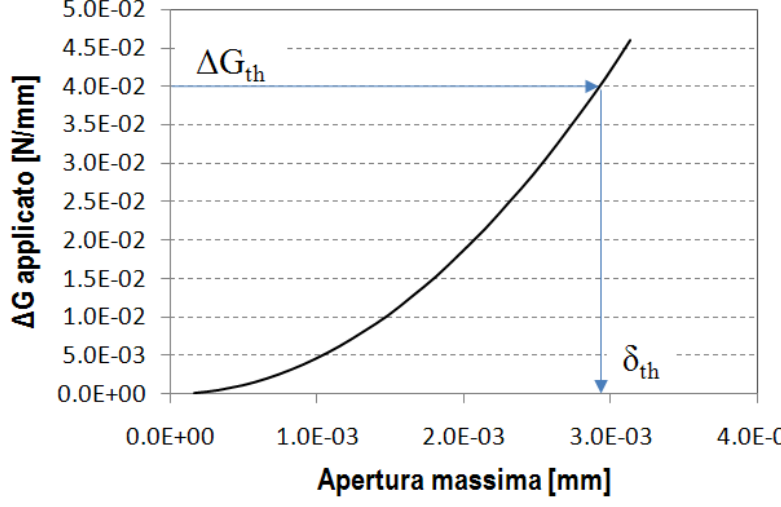
Figura 6: Determinazione del valore di δ th